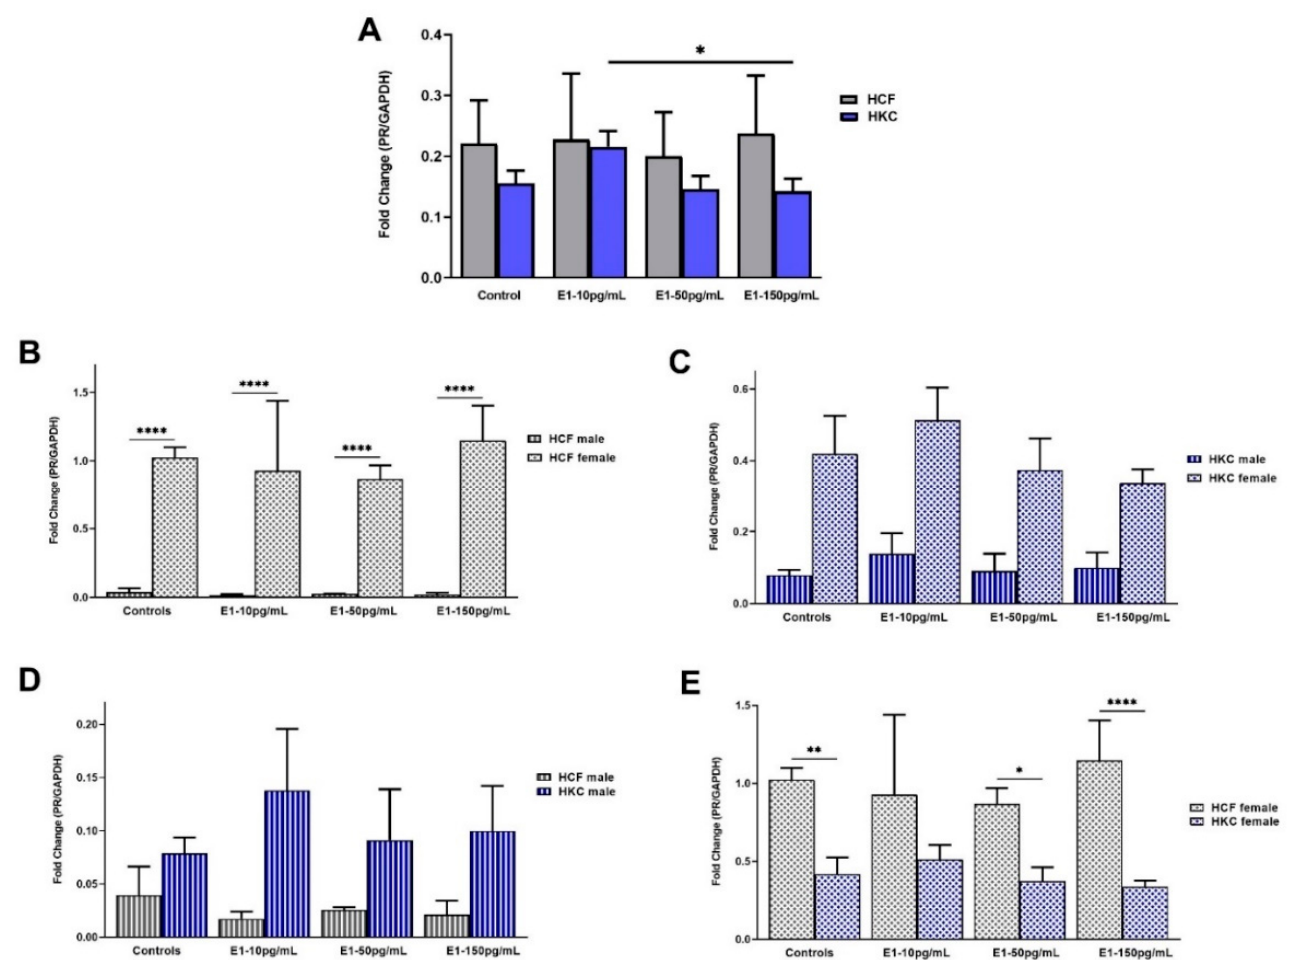
Figure 2. Expression of PR in 3D HCFs and HKCs in response to 10, 50, 150 pg/mL E1 stimulation for four weeks. ( A ) Overall PR expression in HCFs and HKCs ( n = 6). ( B ) Sex-specific expression of PR in HCFs ( n = 3). ( C ) Sex-specific PR expression in HKCs ( n = 3). ( D ) Male-specific PR expression in HCFs vs. HKCs ( n = 3). ( E ) Female-specific expression of PR in HCFs vs. HKCs ( n = 3). * p < 0.05, ** p < 0.01, and **** p < 0.0001.